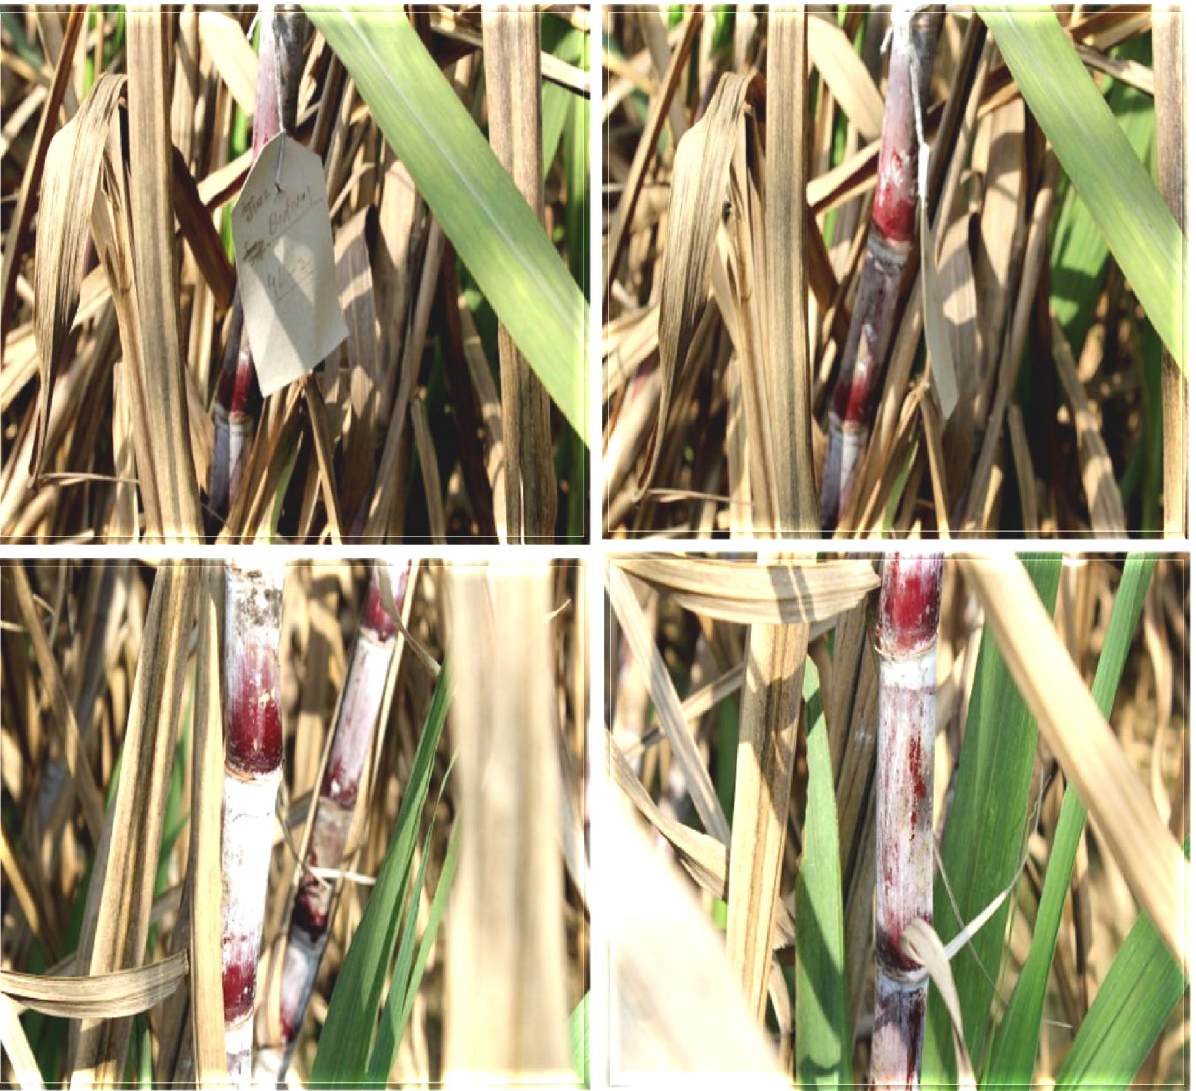
Figure 14. Five sugarcane transgenic lines from 15 V 1 -generation free of any kind of insect attack and tolerant to glyphosate spray 3000 mL/ha) were screened as V 2